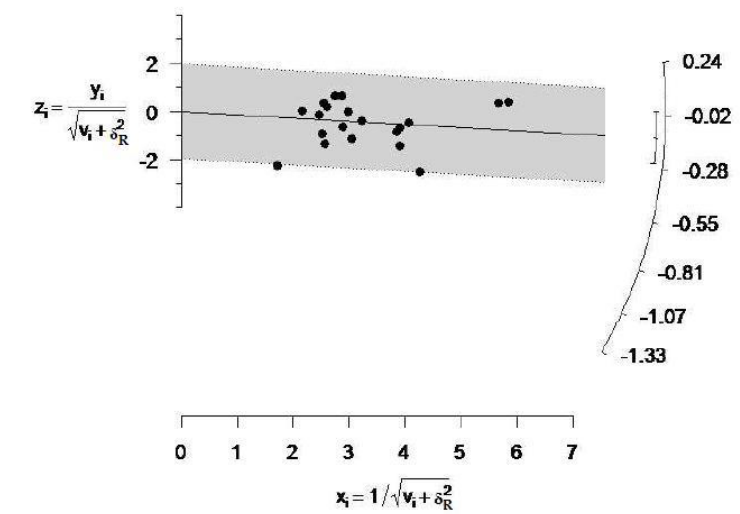
Figure 5. Radial plot for random effects model